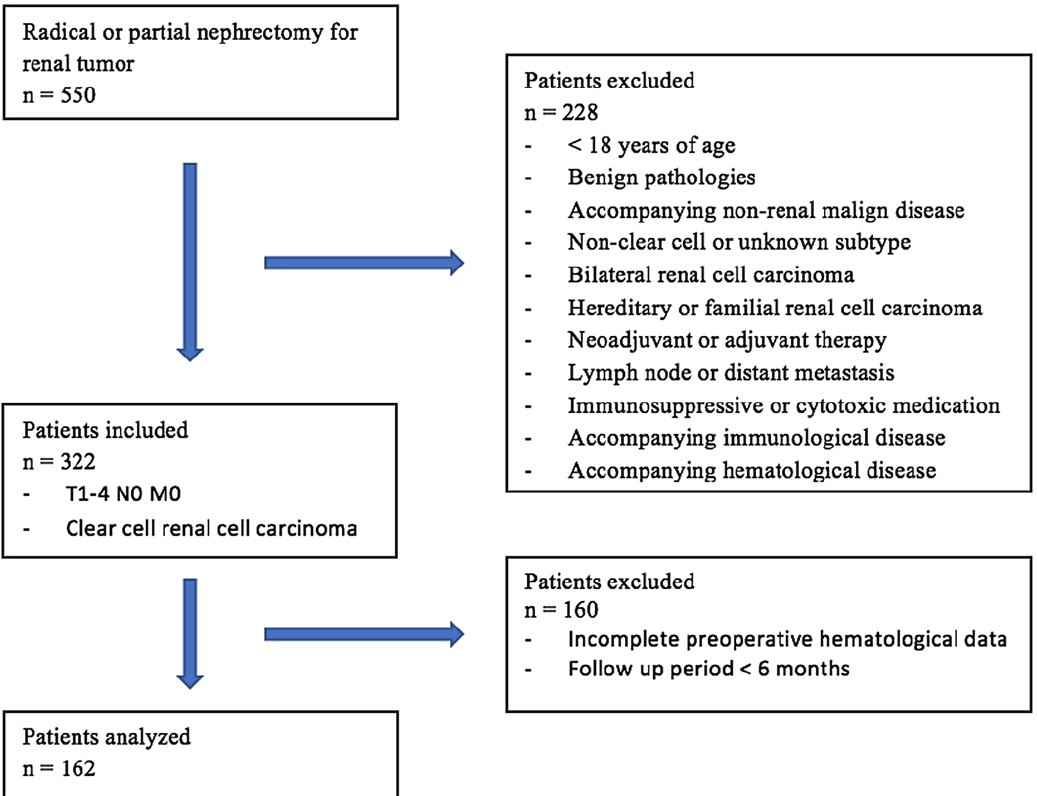
Figure 3 - Optimal cut-off levels for (A) albumin / globulin ratio (AGR), (B) neutrophil / lymphocyte ratio, (C) platelet / lymphocyte ratio (PLR), and (D) lymphocyte / monocyte ratio(LMR) were applied with receiver operating characteristic (ROC) curves for disease-free